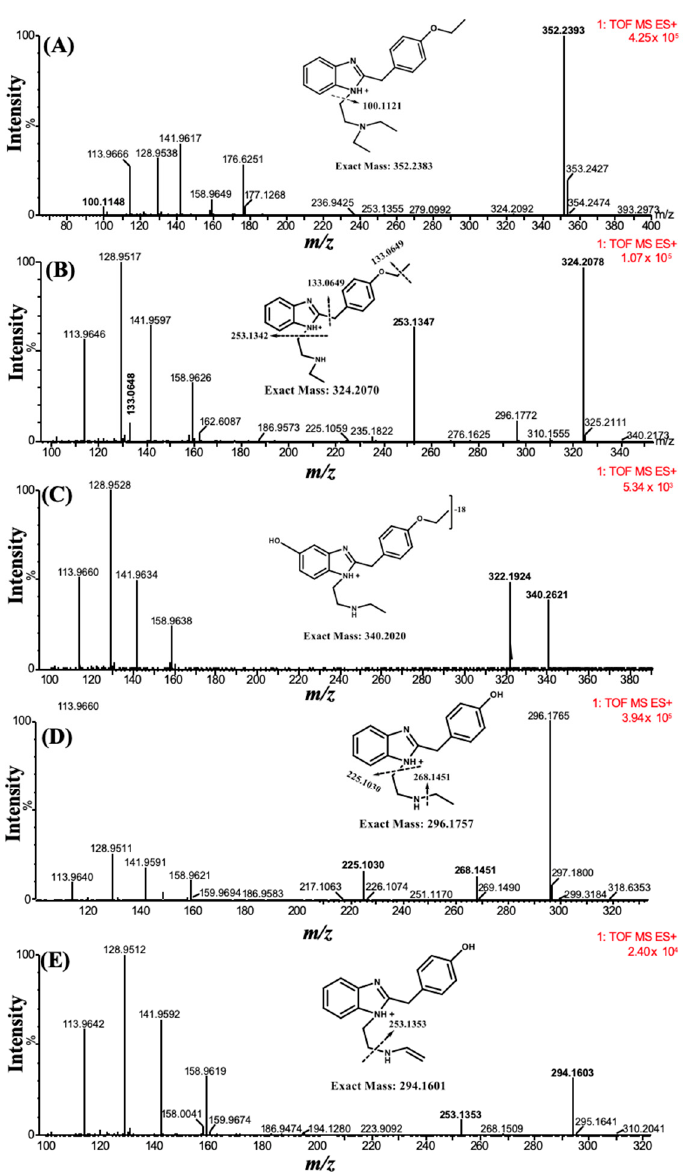
Figure 2. High-resolution mass spectra, their corresponding structure, and fragmentation pattern of ( A ) etazene, ( B ) M1, ( C ) M2, ( D ) M3, and ( E ) M4. All metabolites were tentatively identified based on high-resolution MS and MS/MS of key fragments.